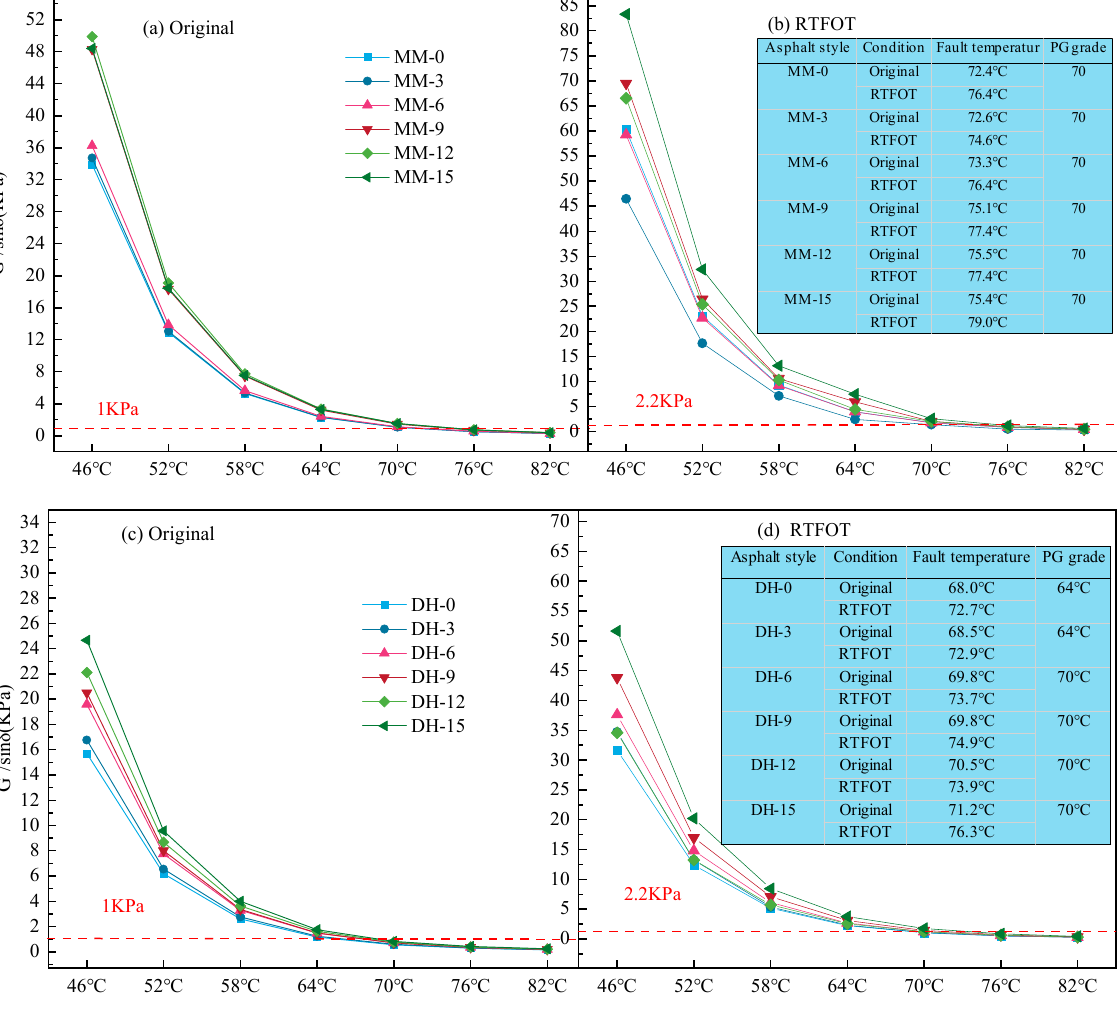
Figure 3. Rutting factor and PG grading of 70# and 90# asphalt with different lignin contents. ( a – d ) rutting factors representing different asphalts before and after short ‐ term aging